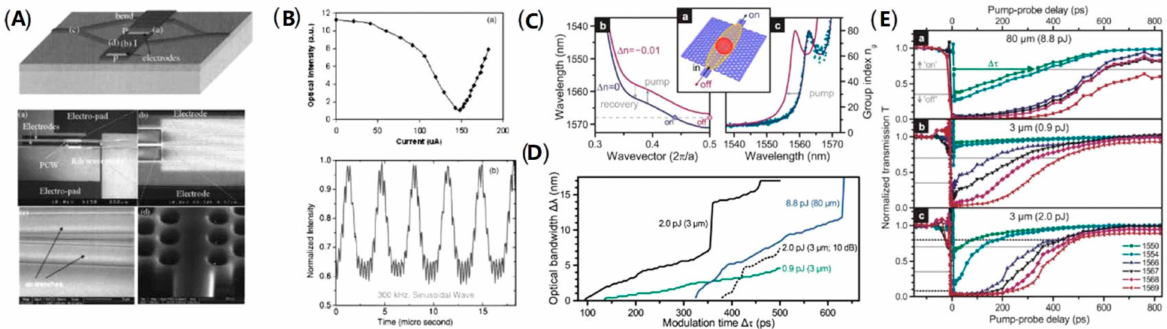
Figure 4. The structure and performance of silicon photonic crystal modulator. ( A ) Schematic diagram and SEM image of the silicon photonic crystal modulator [42]. ( B ) Modulation characteristics include intensity with injection current and modulation curve [42]. ( C ) Dispersion engineered photonic crystal modulator: schematic, band structure, and group index [43]. ( D ) The relationship between optical bandwidth and the modulation time [43]. ( E ) The transmission through the waveguide as a function of the time delay